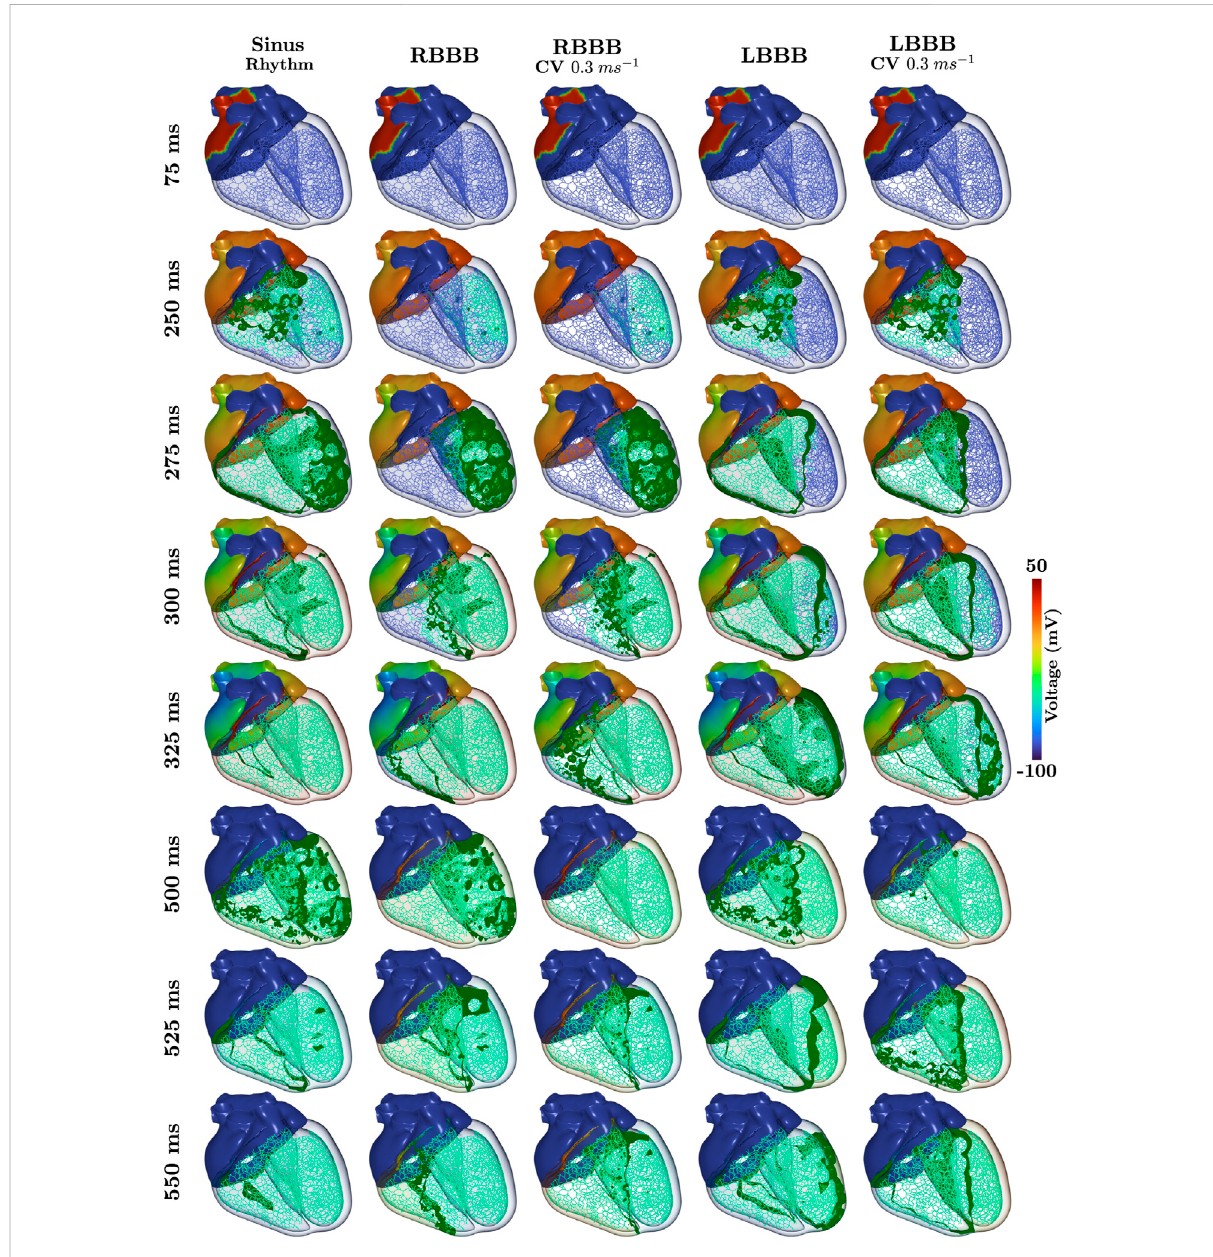
FIGURE 4 Time-course of the transmembrane voltage within the heart for sinus rhythm and BBBs with both normal and halfed CV in the respective affectedventricle.Greenisosurfaceswithintheventriclescorrespondtoamembranevoltageof − 40 mVandthecolormapcorrespondstotheatrial trans-membrane